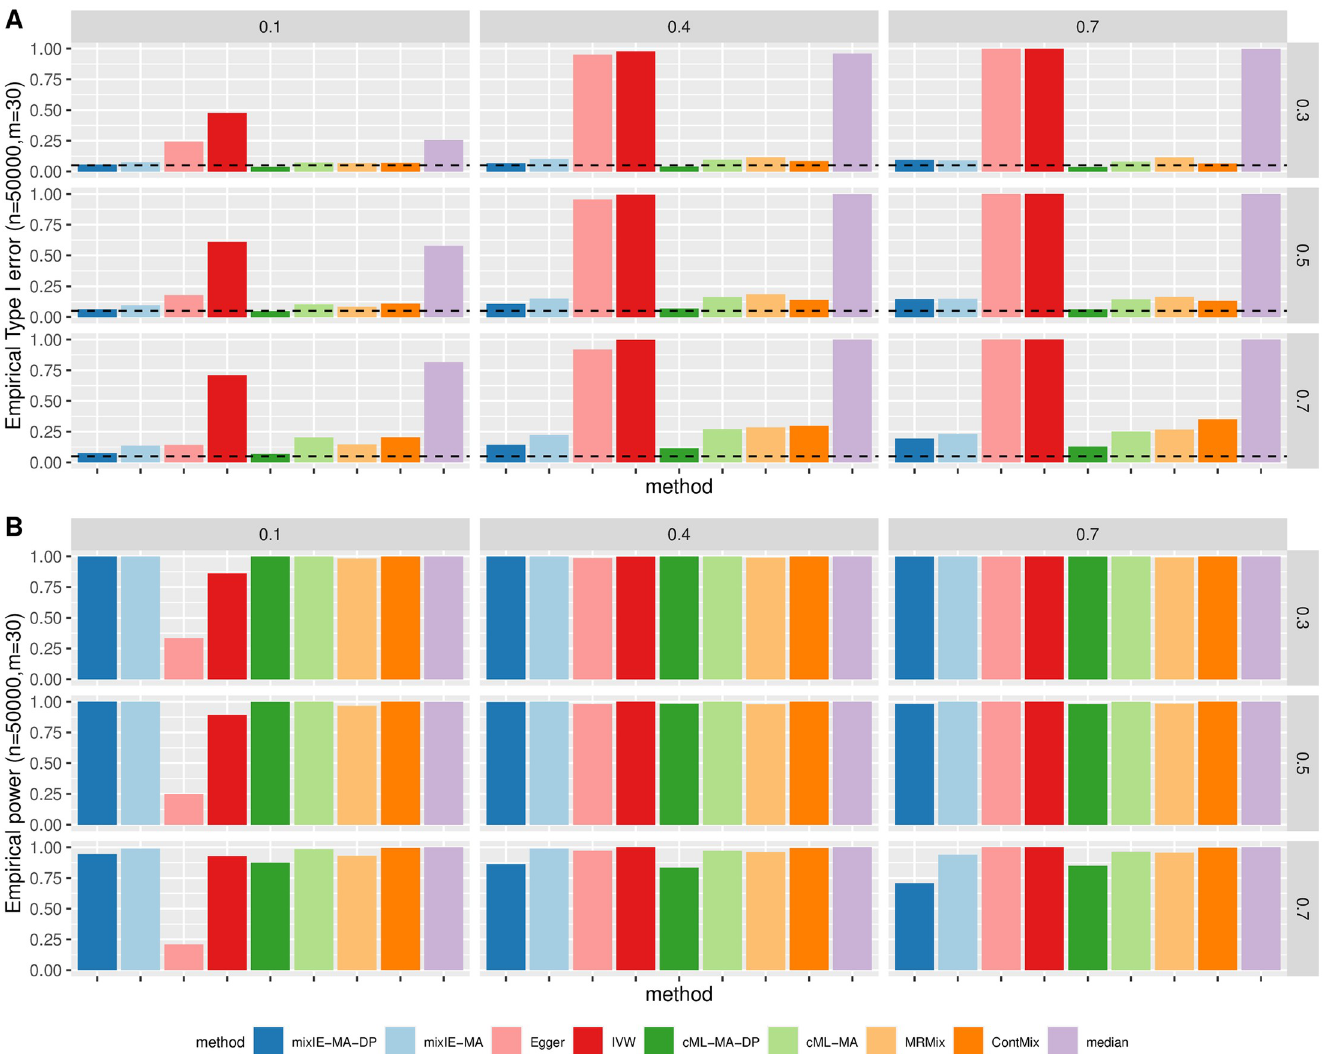
Fig 6. Simulation results with directional pleiotropy and InSIDE violated. A: Empirical type-I error; B: Power with sample size n = 50 000 and m = 30. Each column corresponds to b = 0.1, 0.4, 0.7 and each row corresponds to 30%, 50%, 70% invalid